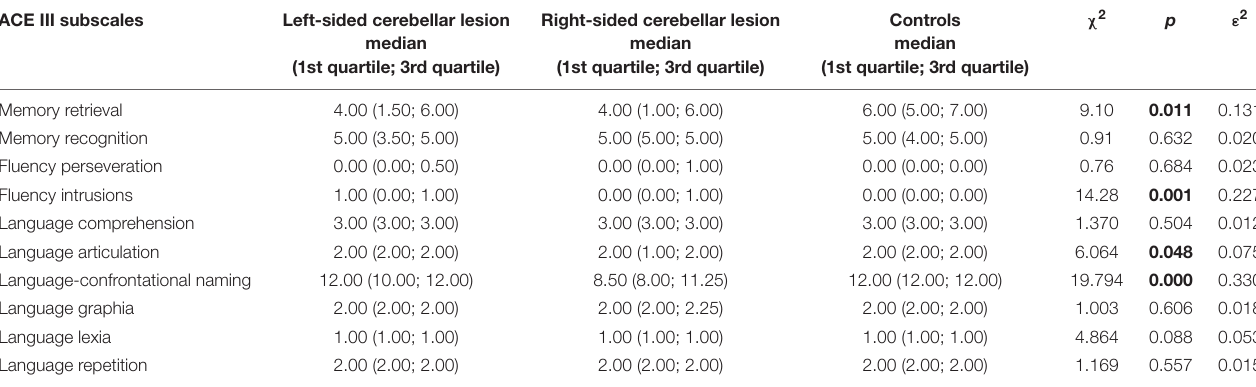
Left-sided cerebellar lesion vs. controls